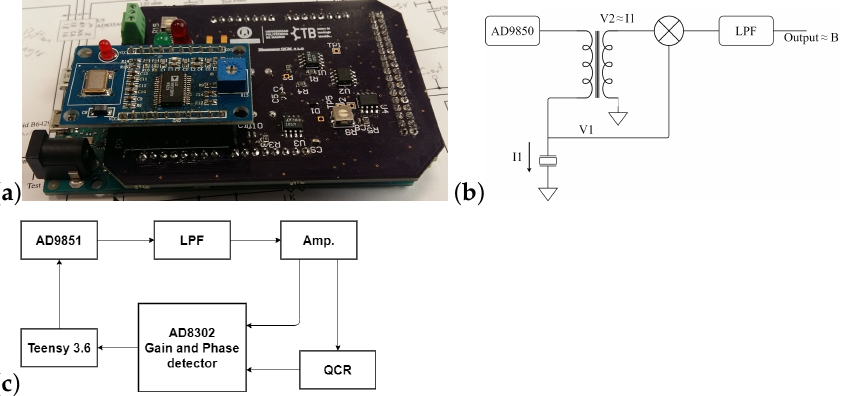
Figure 3. ( a ) ViSQCT sensor. ( b ) ViSQCT sensor simplified diagram of the signals acquisition system. ( c ) Open QCM R (cid:13) signal acquisition